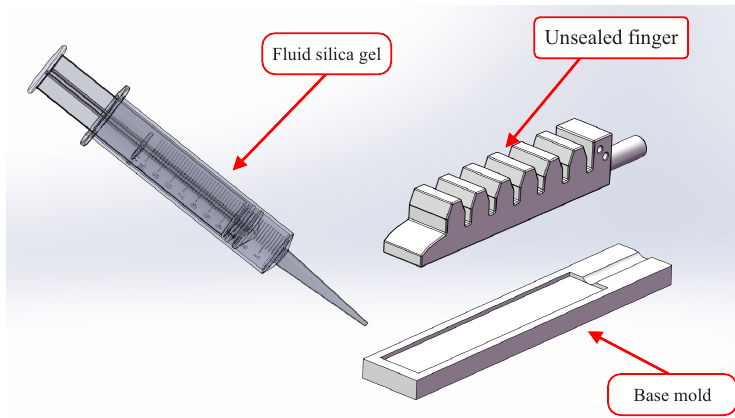
Figure 4. Injection molding process of the base